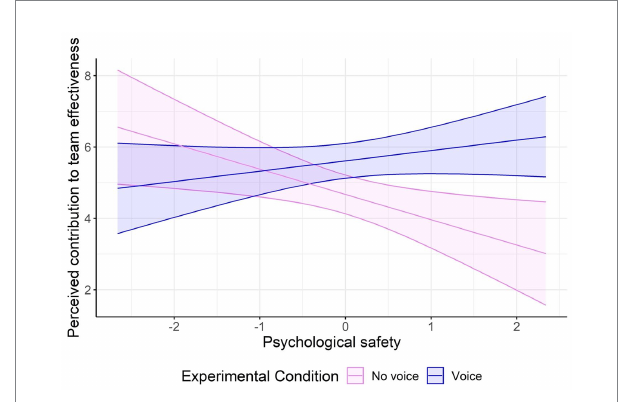
FIGURE 1 Interaction effect between experimental condition (no voice vs. voice) at different levels of psychological safety on perceived contribution to team